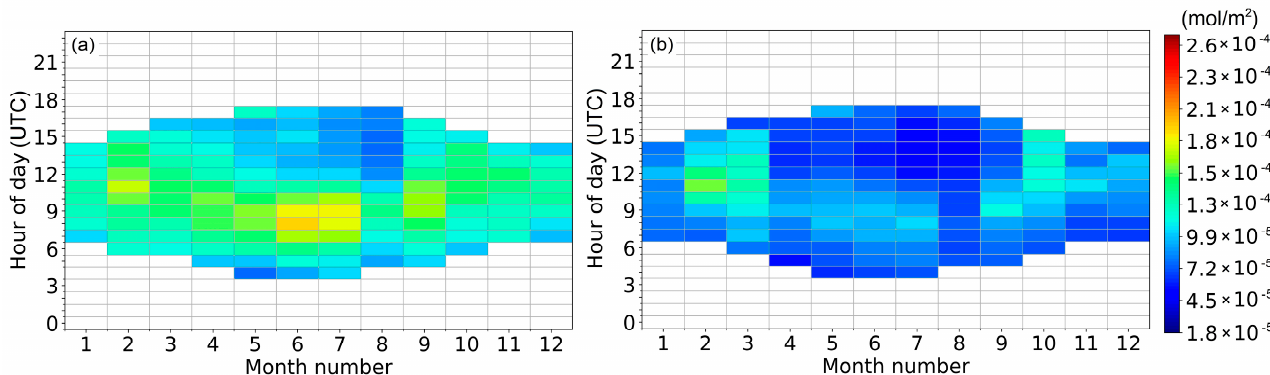
Figure 5. Hourly and monthly variation of TC-NO 2 for ( a ) weekdays and ( b ) weekends over the period 2017–2022.